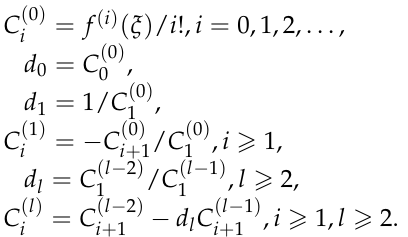
Algorithm 1. Viscovatov’s algorithm to calculate the coefficients d 0 , d 1 , d 2 , . . .